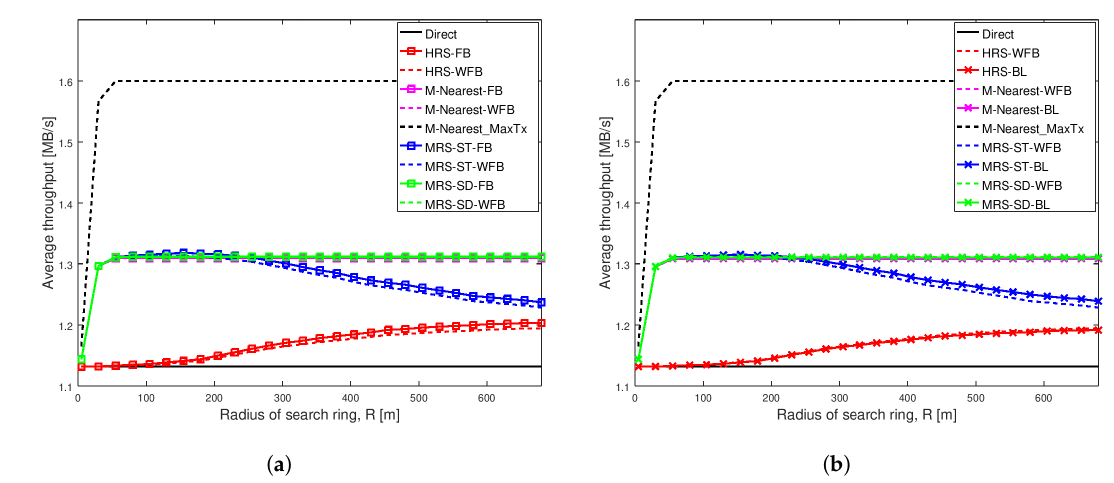
Figure A1. Average throughput of different schemes when Shape = 1.001 and Scale = 0.001 in a network having width of 1000 m. ( a ) Different battery power levels not considered in relay selection; ( b ) Different battery power levels considered in relay selection.